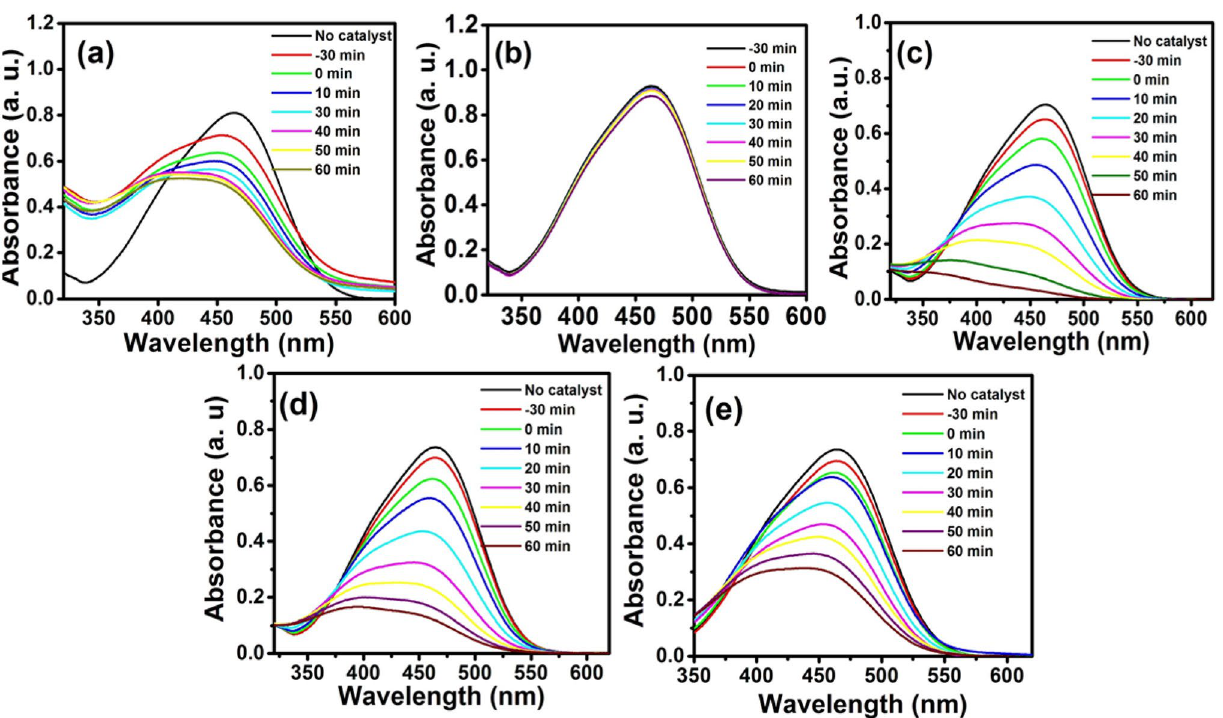
Fig. 7 Photo-degradation study of methyl orange dye under light illumination containing photocatalyst a Z1, b Z2, c Z3, d Z4 and e Z5